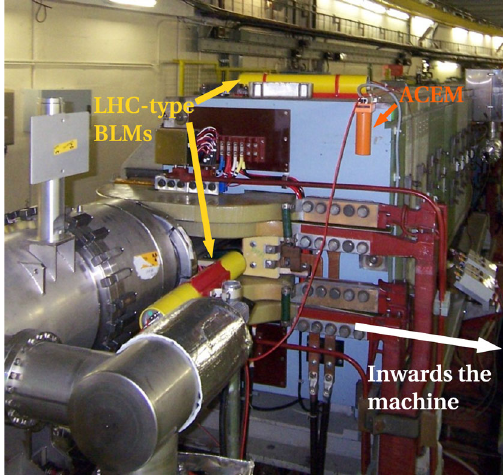
FIG. 14. ACEM detector mounted on the main magnet unit 16. The yellow cylinders on top of the magnet and parallel to the extraction magnetic septum are new BLMs-LHC type under tests.